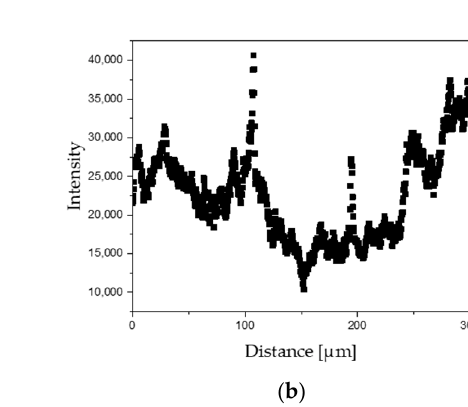
Figure 6. Influence of the laser beam on tissue autofluorescence. ( a ) Autofluorescence and line scan on fluorescence images; ( b ) intensity of light excited in autofluorescence—disappearance of autofluorescence at the laser burning site.